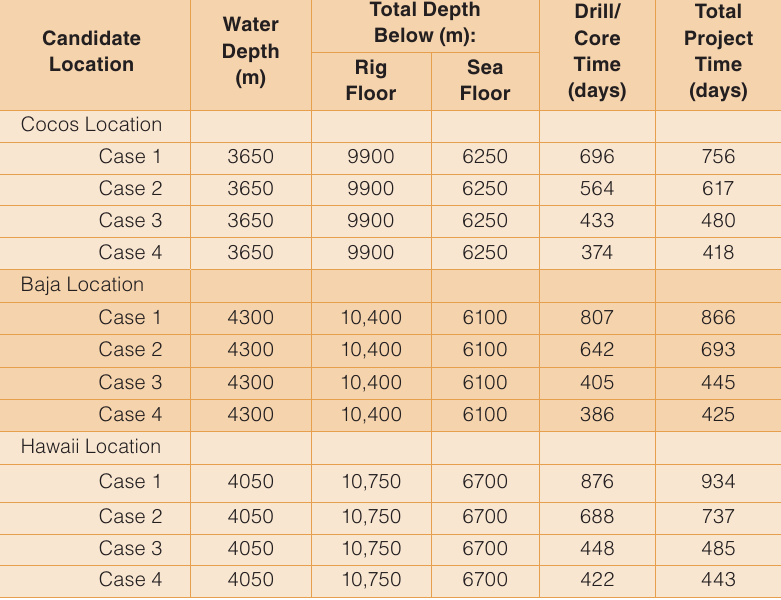
Table 1. Operational time estimates (based on current technologies).